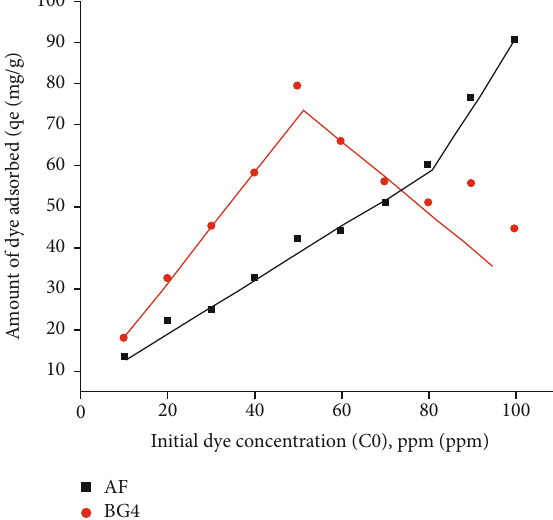
Figure 7: E ff ect of adsorbent dose on dye removal e ffi ciency of HUAC.